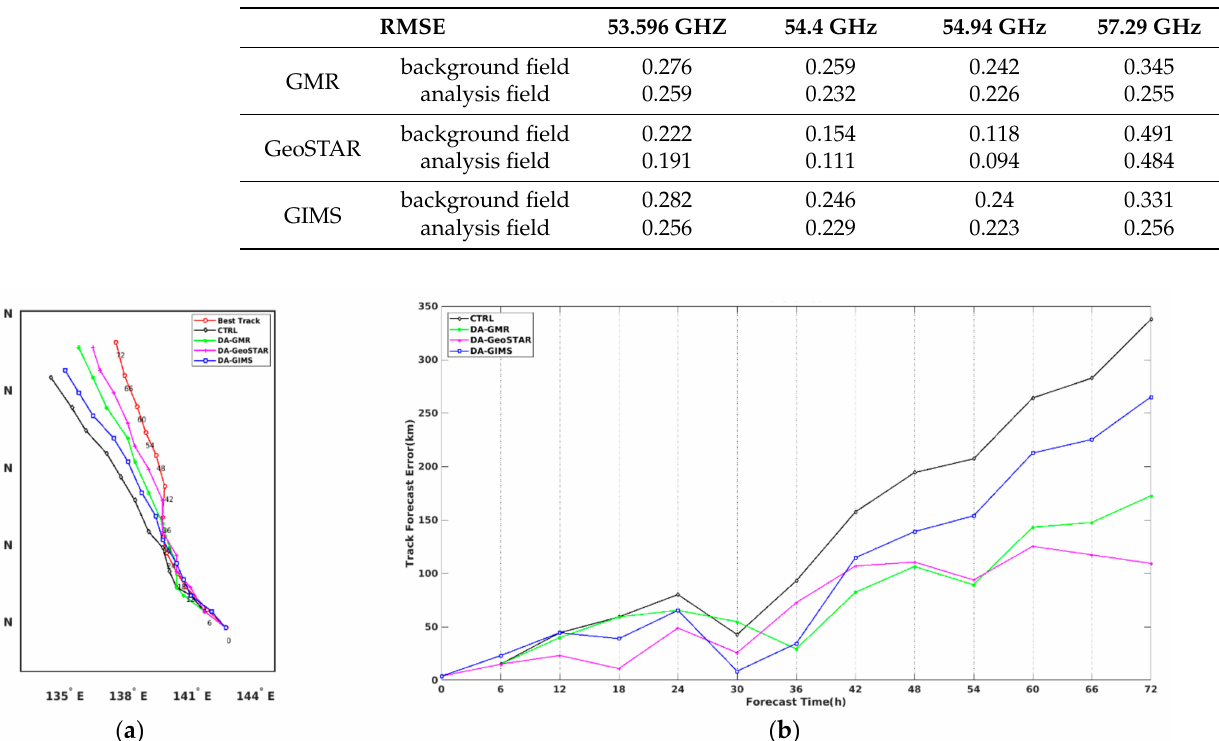
Figure 13. Scatter plots of model-calculated brightness temperature versus the observations (K) of GIMS for ( a – d ) background and ( e – h ) analyses valid at 06:00 UTC on 8 October 2019. ( a , e ) represents channel-4 53.596 GHz, ( b , f ) represents channel-5 54.4 GHz, ( c , g ) represents channel-6 54.94 GHz, and ( d , h ) represents channel-8 57.29 GHz. Table 8. RMSE (K) of brightness temperature calculated from background field and analysis field relative to observation.